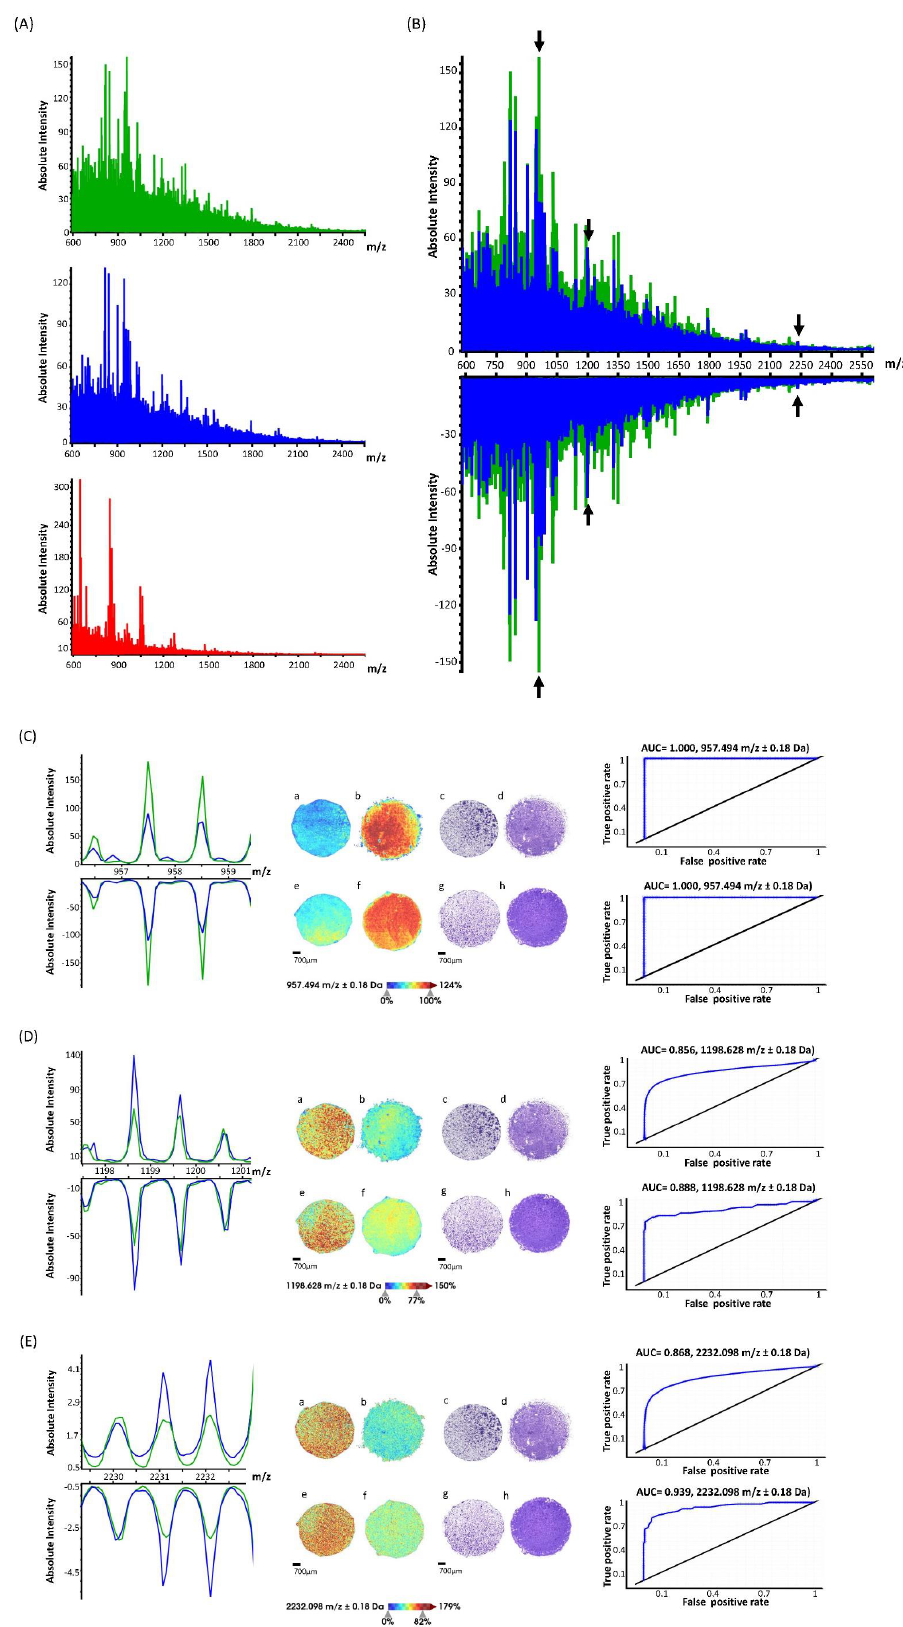
Figure 4. Comparison of peptide MS profiles of different cell lines processed with cytospin. ( A ) MALDI mass spectrometry spectra of the cell lines AMO WT (green), AMO BZB (blue), and H929 GFP/LUC (red). ( B ) MALDI MS overlay spectra of cell lines AMO BZB (blue) and AMO WT (green) in replicate 1 (spectra up) and replicate 2 (spectra down) samples. Representative peak discriminators, indicated with black arrows, are shown in enlarged areas for m/z 957.494 (( C ), spectra left), showing high intensity in AMO WT cells (spectrum in green), 1198.628 (( D ), spectra left), and 2232.098 (( E ), spectra left), which show high intensity in the AMO BZB (spectrum in blue) cells. Ion density maps of these representative peptide peaks are shown in the AMO BZB cells for m/z 957.494 (( C ) − a, replicate 1; ( C ) − e, replicate 2), m/z 1198.628 (( D ) − a, replicate 1; ( D ) − e, replicate 2), and for m/z 2232.098 (( E ) − a, replicate 1; ( E ) − e, replicate 2). Likewise, the ion density map of the same peptides is shown in the AMO WT cells for m/z 957.494 (( C ) − b, replicate 1; ( C ) − f, replicate 2), m/z 1198.628 (( D ) − b, replicate 1; ( D ) − f, replicate 2), and for m/z 2232.098 (( E ) − b, replicate 1; ( E ) − f, replicate 2). Hematoxylin and eosin staining of the cytospin AMO BZB (( C ) − c, ( D ) − c, ( E ) − c replicate 1; ( C ) − g, ( D ) − g, ( E ) − g replicate 2), and AMO WT (( C ) − d, ( D ) − d, ( E ) − d replicate 1, ( C ) − h, ( D ) − h, ( E ) − h replicate